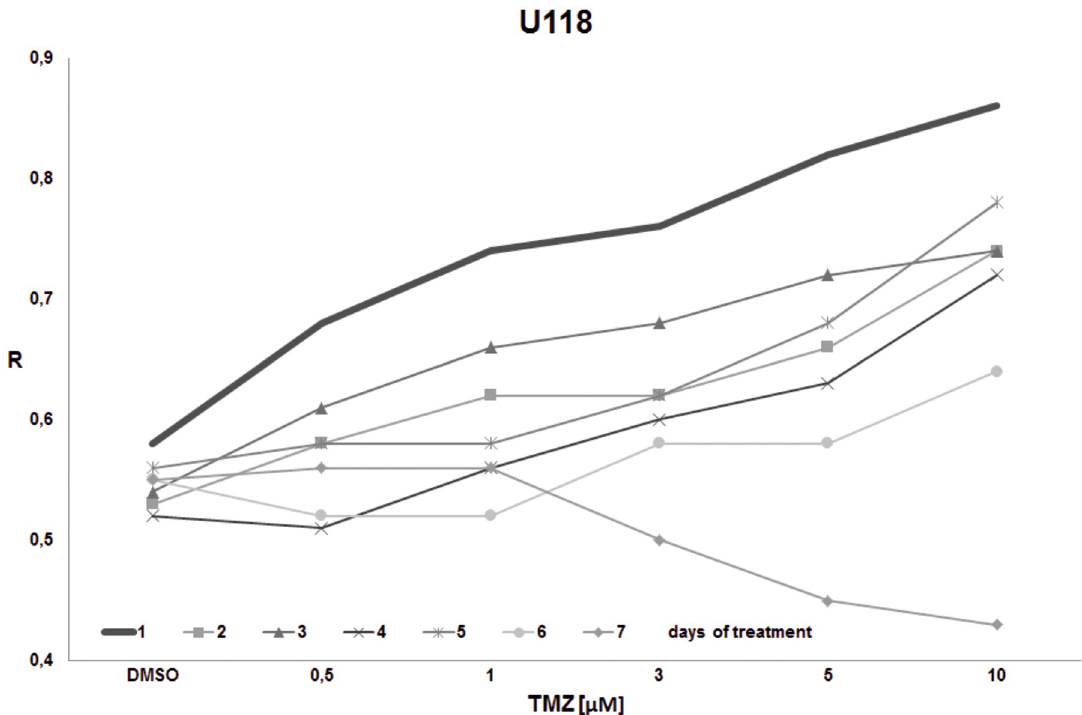
Fig 10. The impact of TMZ exposure period on DNA methylation in U118 cell line. U118 cell culture was treated with the given single dose of TMZ (0.5, 1, 3, 5, 10 μ M) and left for 1–7 days. The global DNA methylation was estimated after 1 st , 2 nd , 3 rd , 4 th , 5 th , and 7 th day of incubation. A general hypermethylation is observed, with no initial hypomethylating effect in lower concentration range. Hypomethylation after 7 days starts with concentrations over 1 μ